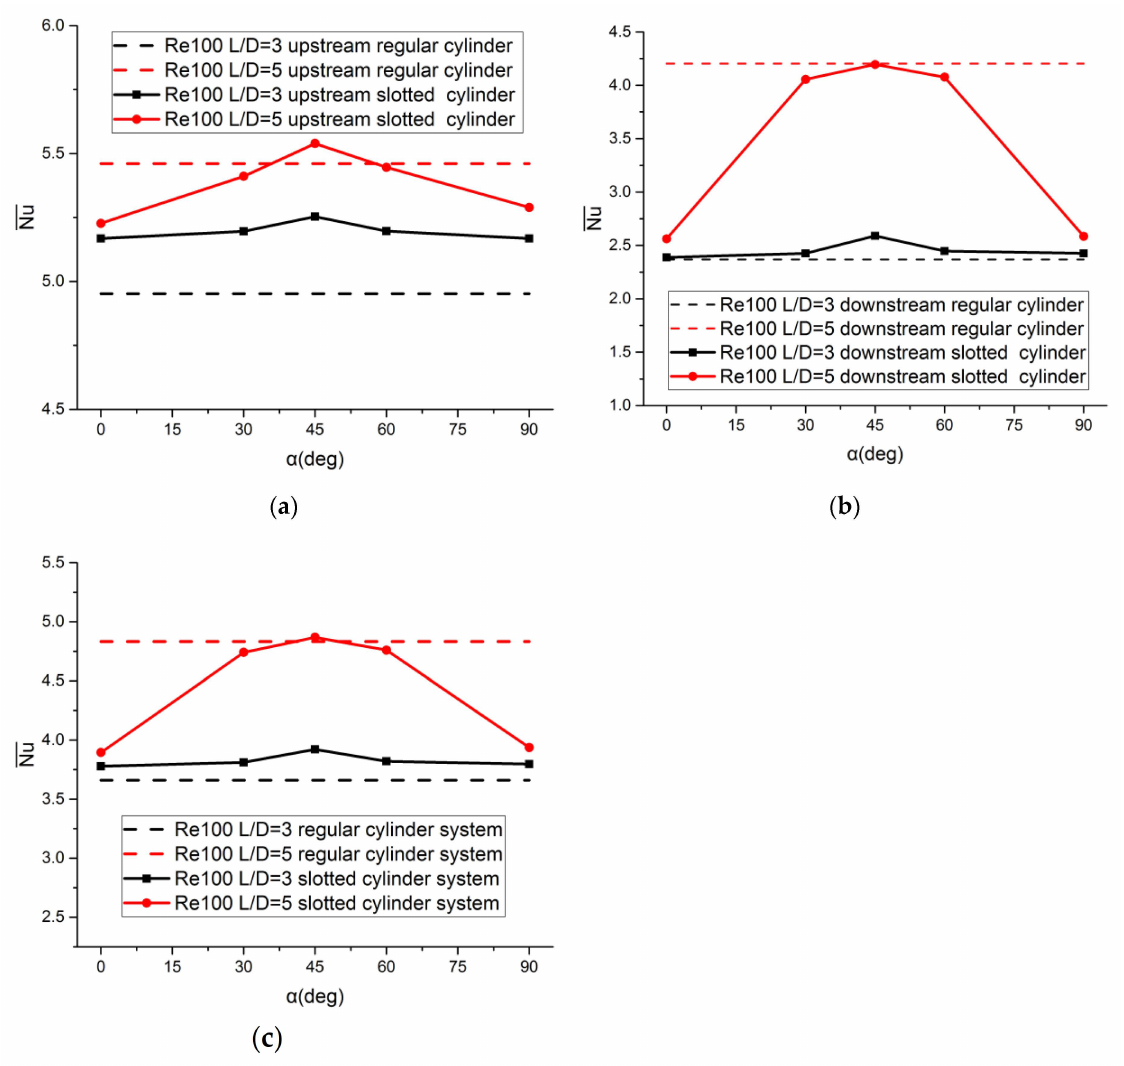
Figure 19. The time mean Nusselt number as a slit with different angles is employed on the upstream cylinder of the tandem array at Re = 100: ( a ) upstream cylinder; ( b ) downstream cylinder; ( c ) array